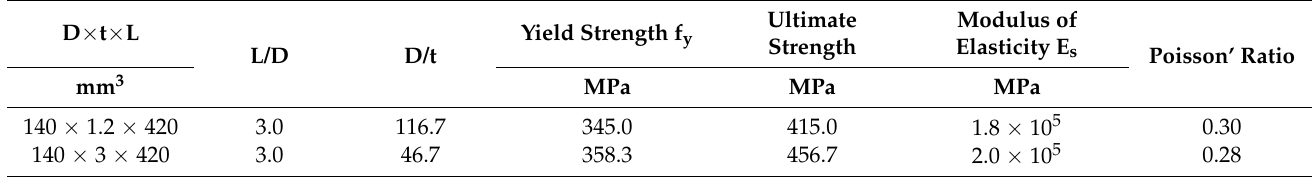
Table 1. Mechanical performances and characteristics of the thin-walled steel tubes.